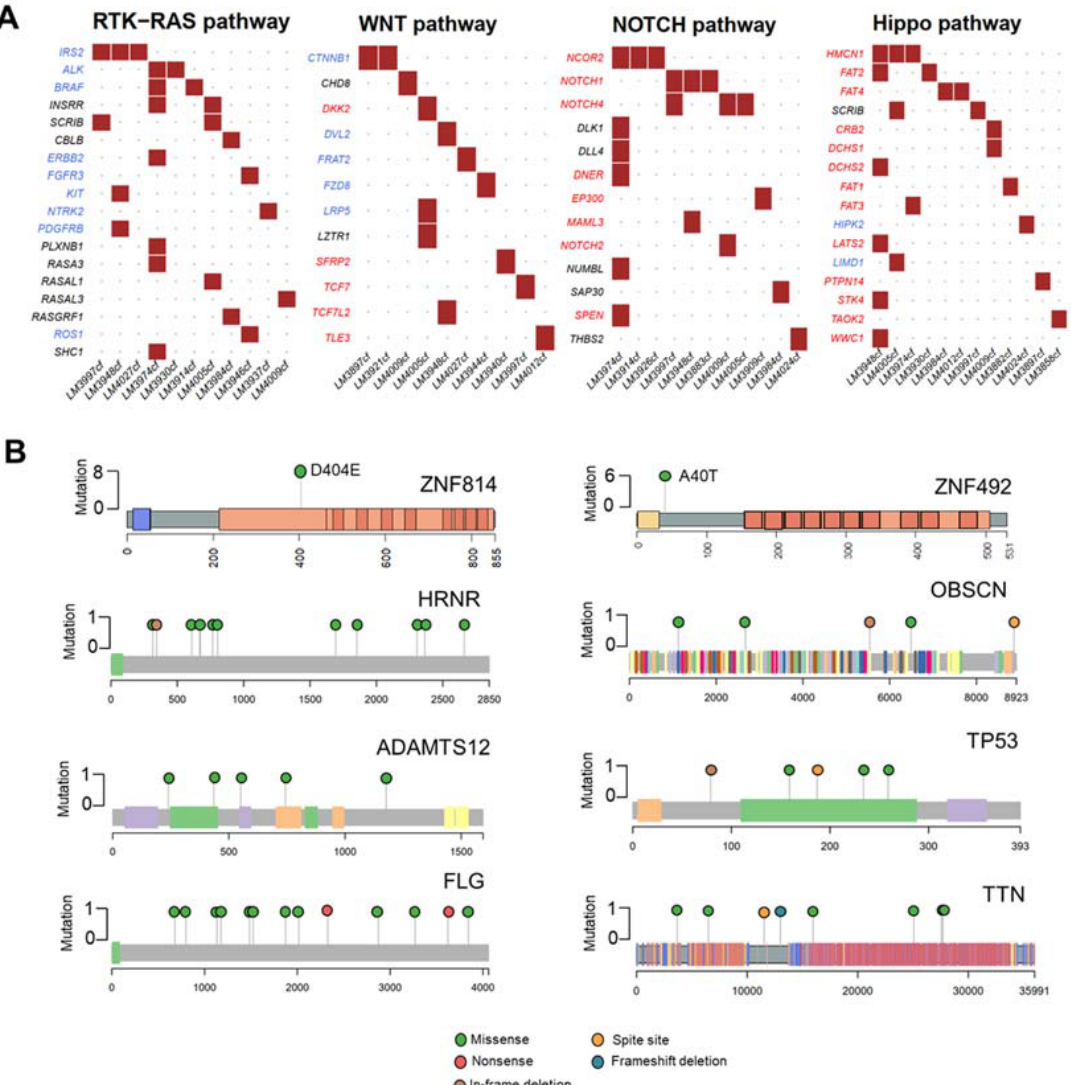
Figure 2. Mutational analysis of the 30 HCC cfDNA samples. ( A ) Mutated genes in HCC cfDNA related to oncogenic pathways. Oncogenes are highlighted in red; tumor suppressor genes are highlighted in blue. ( B ) Lollipop plots displaying mutation distribution and protein domains of the top eight frequently mutated genes and demonstrating the locations of ZNF814 and ZNF492 mutations.